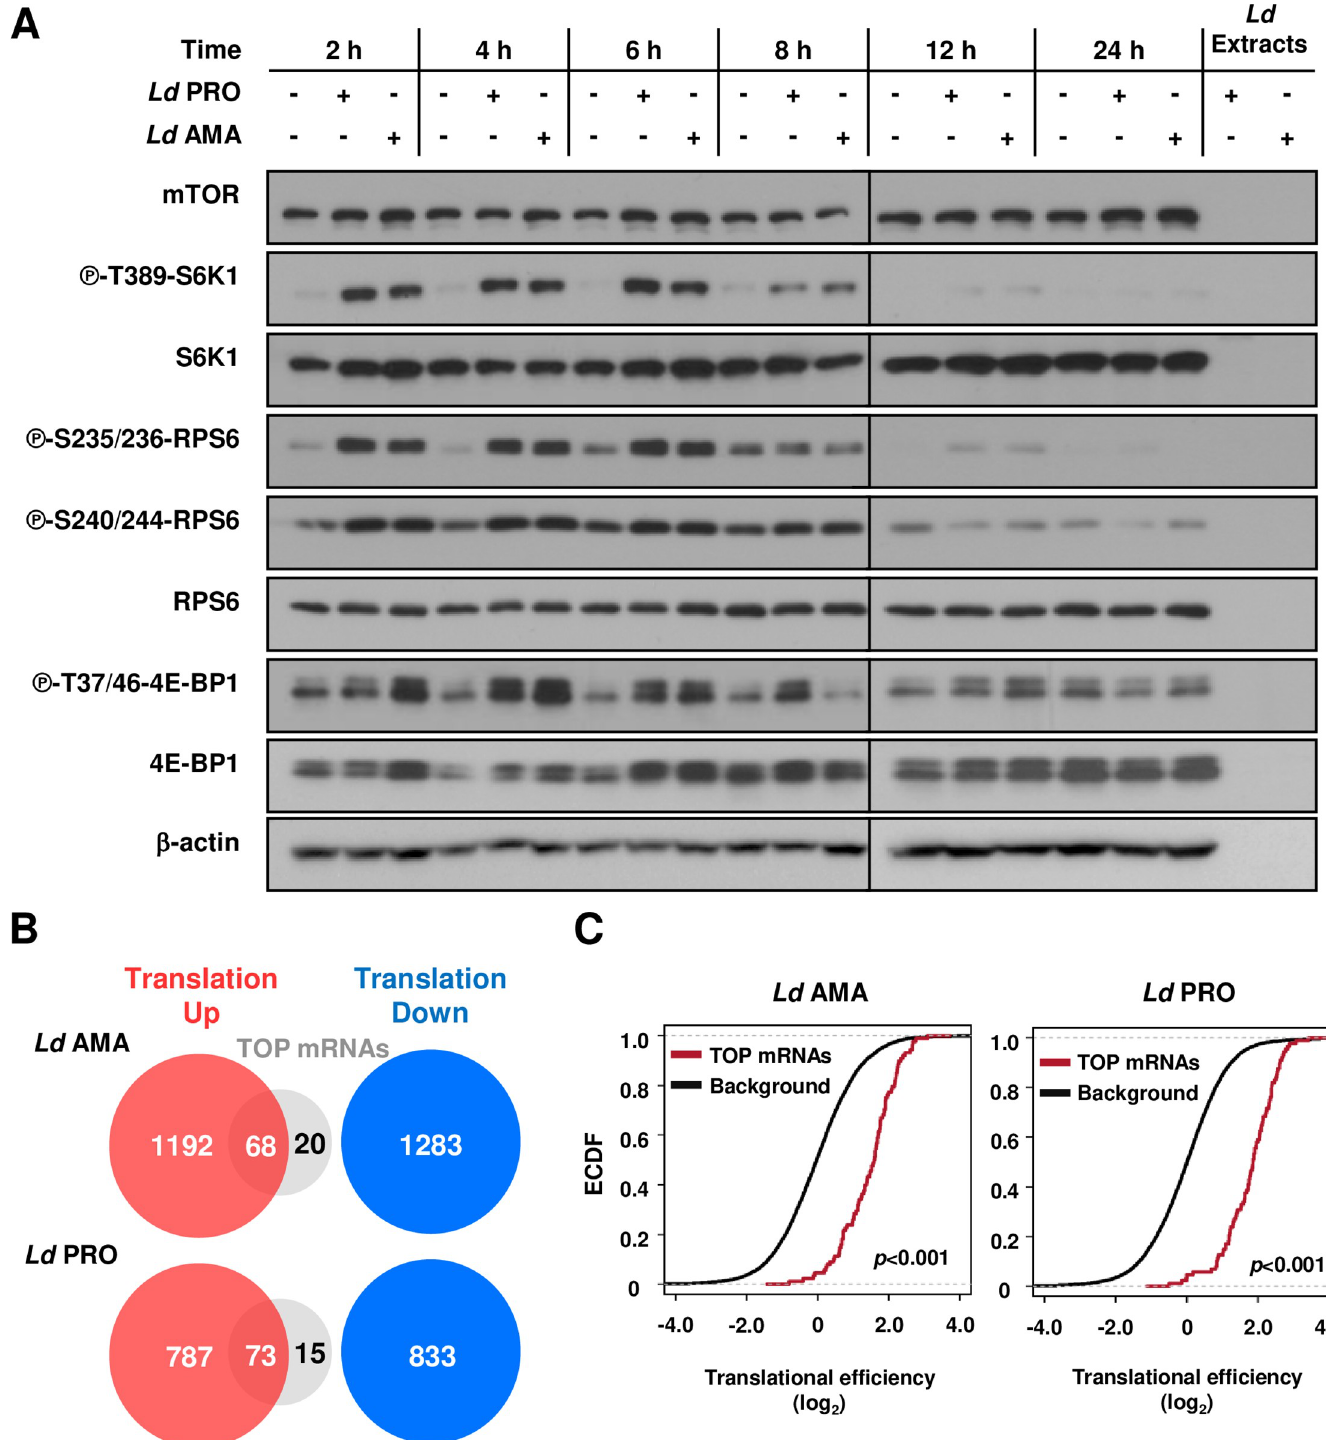
Fig 3. mTOR-sensitive host mRNA translation is activated during L . donovani infection. ( A ) BMDM cultures were inoculated with either Ld AMA or Ld PRO or left uninfected for the indicated times. Phosphorylation and expression levels of indicated proteins were monitored by Western blotting. Total amounts of β -actin were used as a loading control. Total protein extracts from Ld cultures were used to control for any cross-reactivity of the antibodies against parasite antigens. ( B ) Venn diagrams indicating the numbers of transcripts harboring a TOP-motif among translationally activated vs. suppressed transcripts following Ld AMA or Ld PRO infection as compared to control BMDMs. ( C ) Empirical cumulative distribution function (ECDF) of translational efficiencies for TOP mRNAs as compared to those of all detected